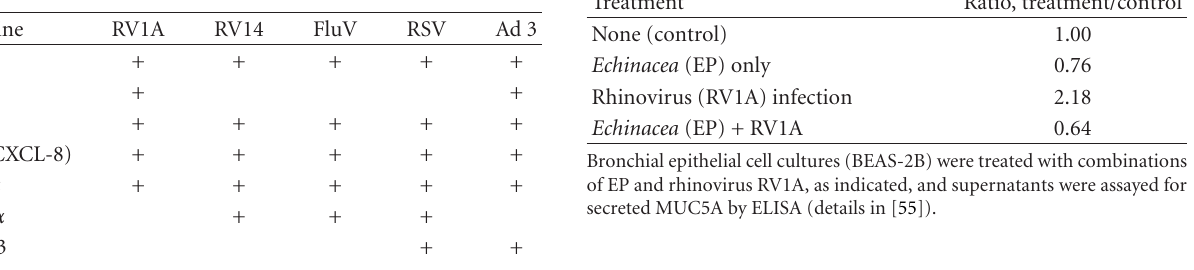
Table 3: Cytokines/chemokines induced by viruses (+) and reversed by EP.